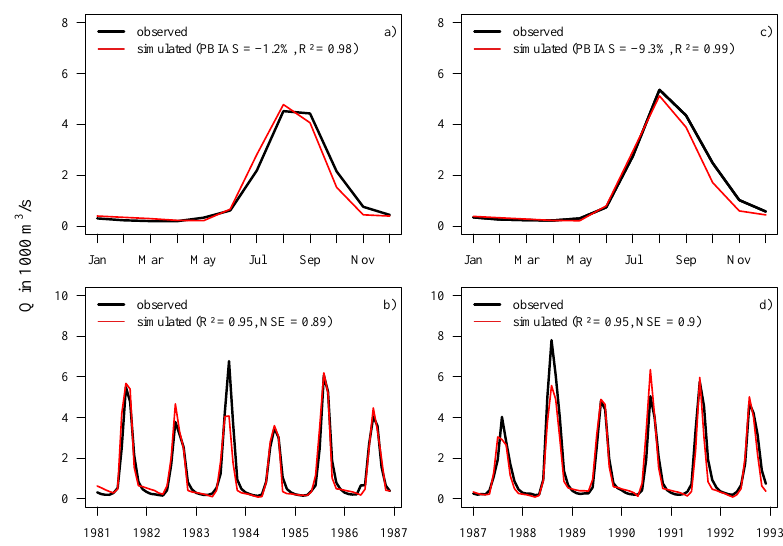
Figure 4. Annual cycle (top row) and monthly (bottom row) simulated discharges for calibration ( a , b ) and validation ( c , d ) periods at gauge El Diem (Sudan Border) using Watch Forcing Data